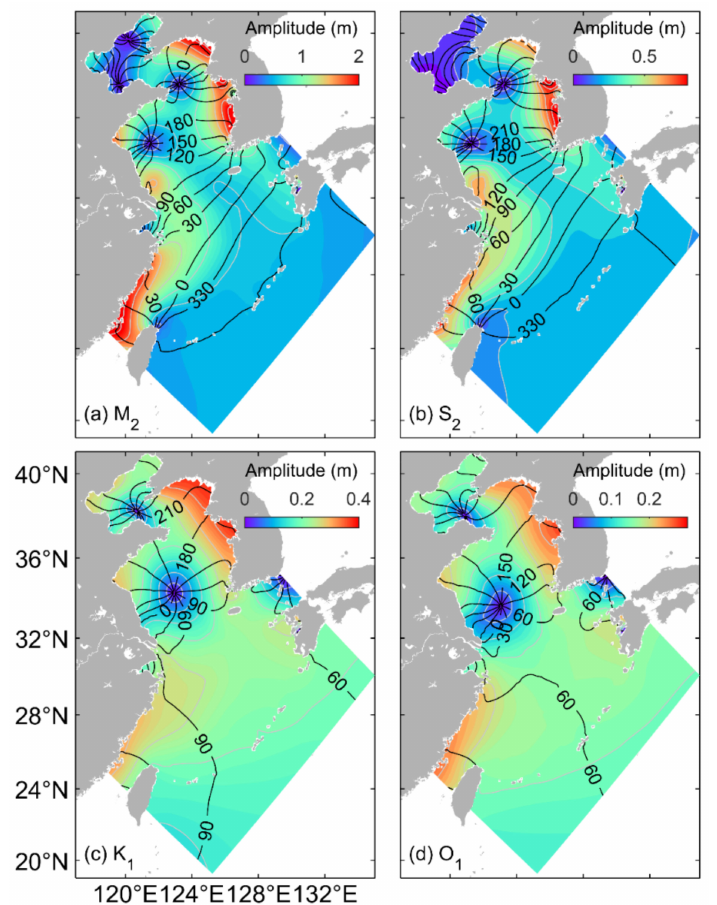
Figure A1. Co-amplitudes and co-phases of ( a ) M 2 , ( b ) S 2 , ( c ) K 1 , and ( d ) O 1 over the China Seas and adjacent deep ocean waters of the northwestern Pacific based on results produced by the Oregon State University (OSU) TPXO ocean tidal model. The phases are in degrees relative to the